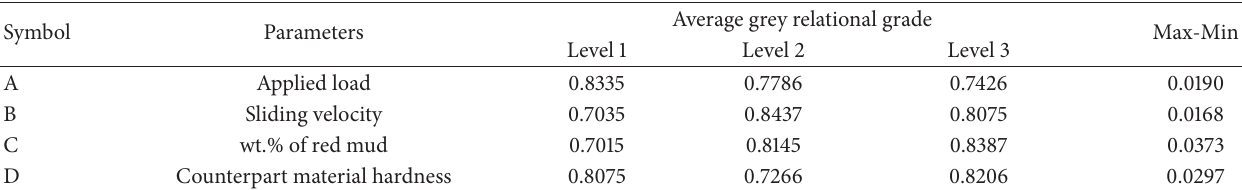
Table 3: Response table for grey relational